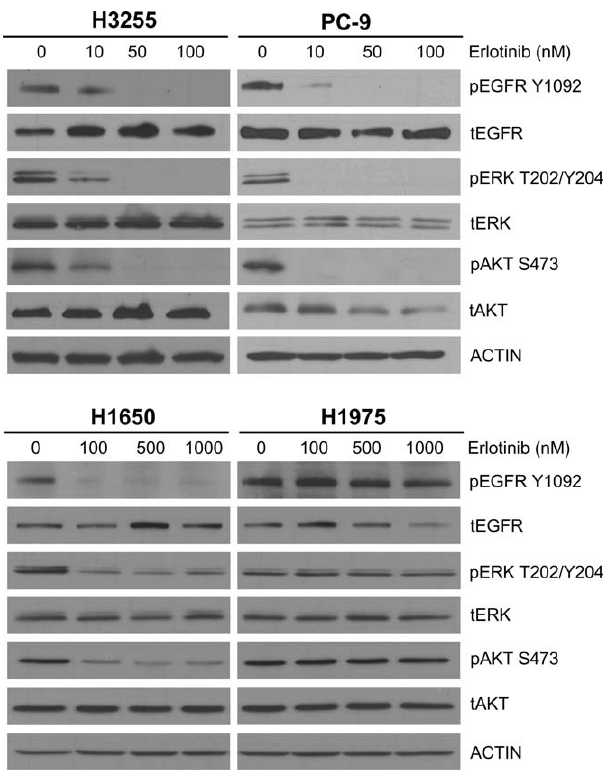
Figure 1. Effects of Erlotinib on EGFR Signaling Pathways in H3255, PC-9, H1650, and H1975 Cells Cells were treated with the indicated concentrations of erlotinib for 6 h. Cell lysates were analyzed by immunoblotting, using the indicated antibodies. t, total protein; p, phospho-protein.